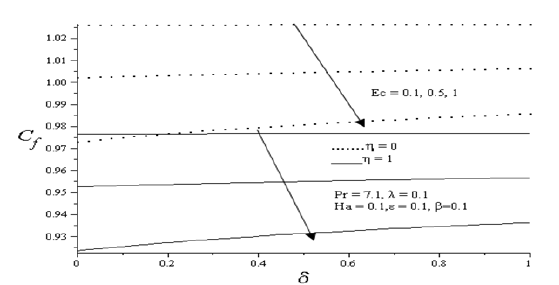
Figure 9. Skin friction with increasing δ and Ec.